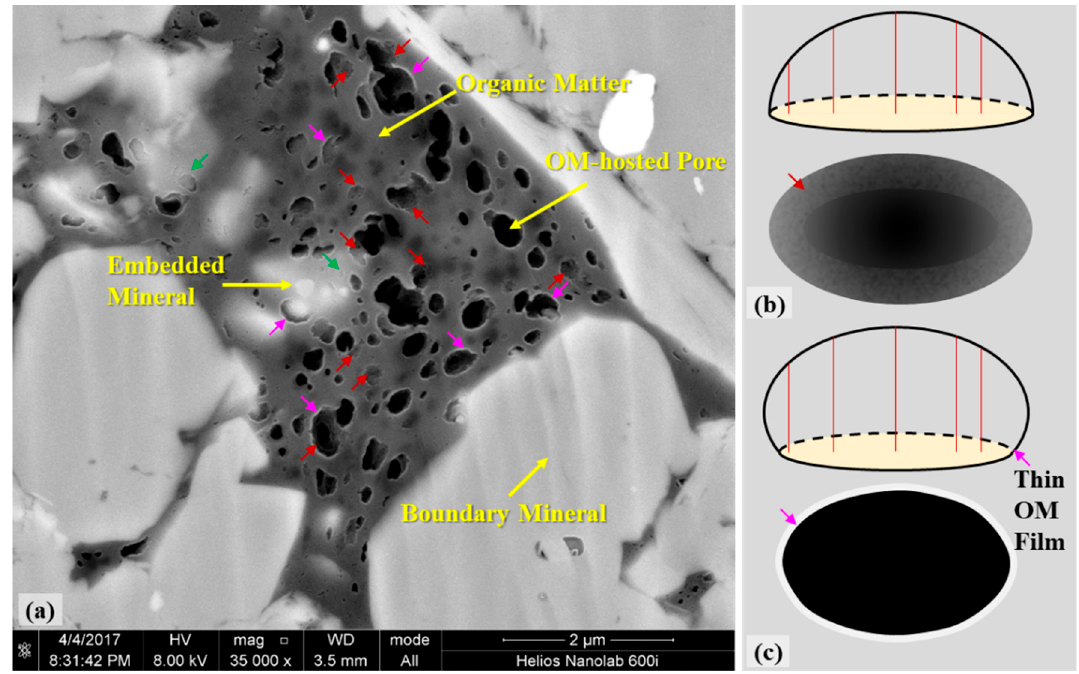
Figure 2. Example of organic matter, OM-hosted pores, minerals of Longamxi Shale, Sichuan Basin ( a ) and an illustration of intersection of OM-hosted pores and SEM section for roughness texture ( b ) and white edge ( c ). The SEM image is from core sample JY1S-4, the red arrow points to the roughness texture, the purple arrow points to the white edge, and the green arrow points to the region with the lower gray level of OM and OM-hosted pores.